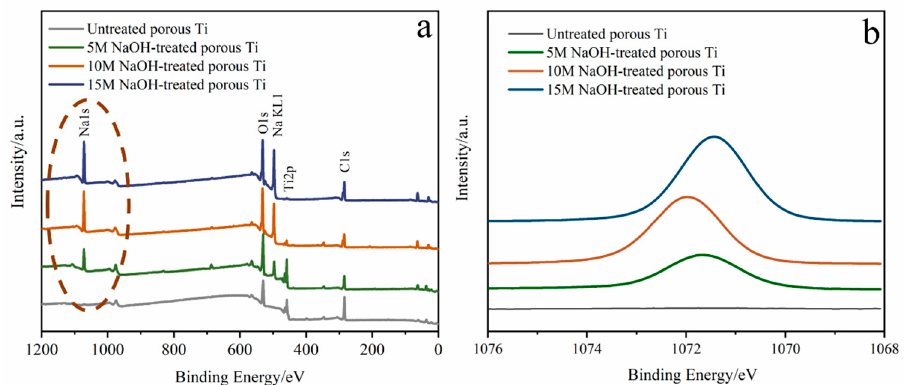
Figure 5. ( a ) XPS full spectrum of porous Ti treated with different NaOH concentrations and ( b ) the high-resolution fine spectrum of Na1s, as circled with brown dashes in ( a ).